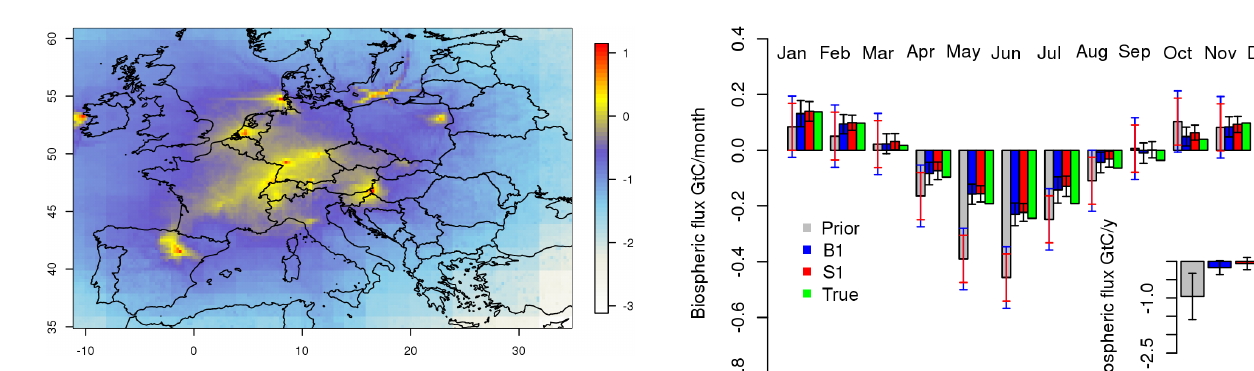
Figure 6. Annual integrated influence for 2007 of the current atmo- spheric network. Footprint influence is presented on a logarithmic scale and units are in log 10 [ppm ( µmolm − 2 s − 1 ) − 1 ]